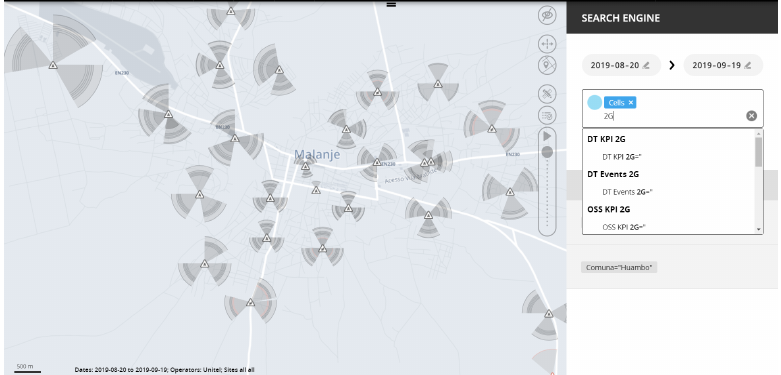
Figure 4. Metric SaaS map interface, highlighting the available 2G cells geolocated in the